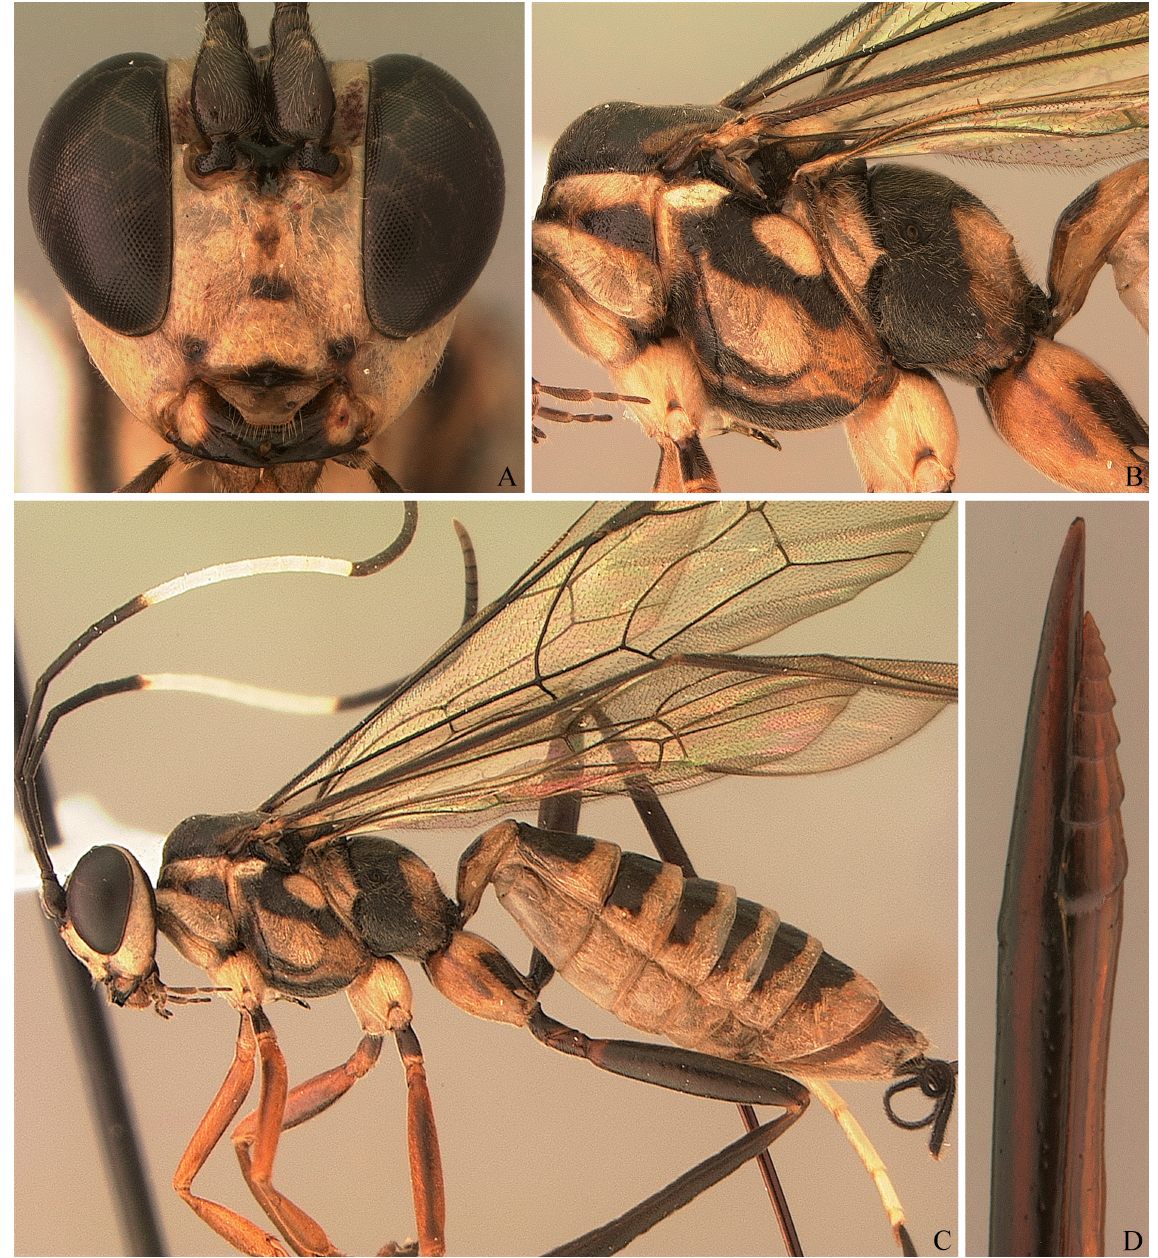
Fig. 4. Distictus apaensis sp. nov., holotype (CNCI), ♀. A . Head, frontal view. B . Mesosoma, left view. C . Habitus. D . Apex of ovipositor,